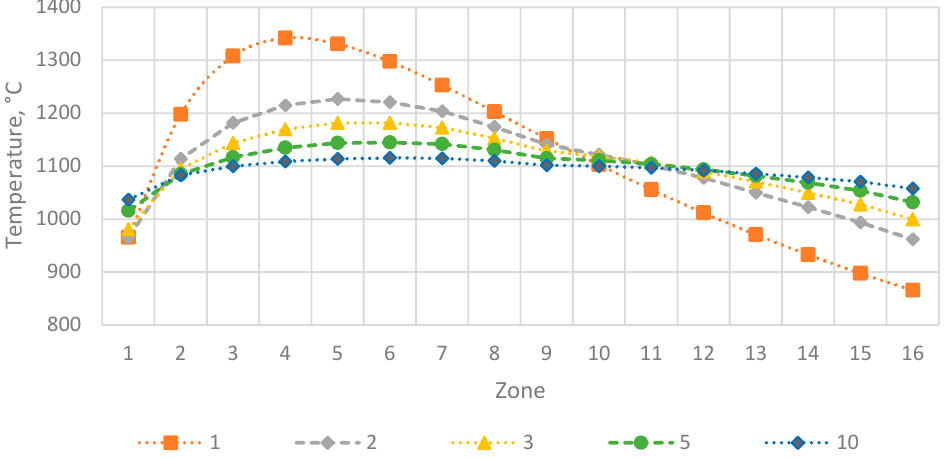
Figure 7. Temperature distribution over the zones of the furnace with variable rate of recirculation of furnace gases with minimum thermal power.